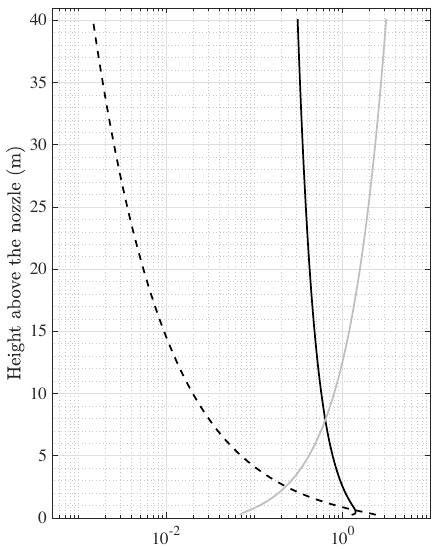
Figure 11. Variation of the fluid dynamic properties over the depth: centerline velocity [m/s] (the black solid line), the half width [m] (the gray solid line), and the overall gas fraction [-] (the dark gray dashed line).